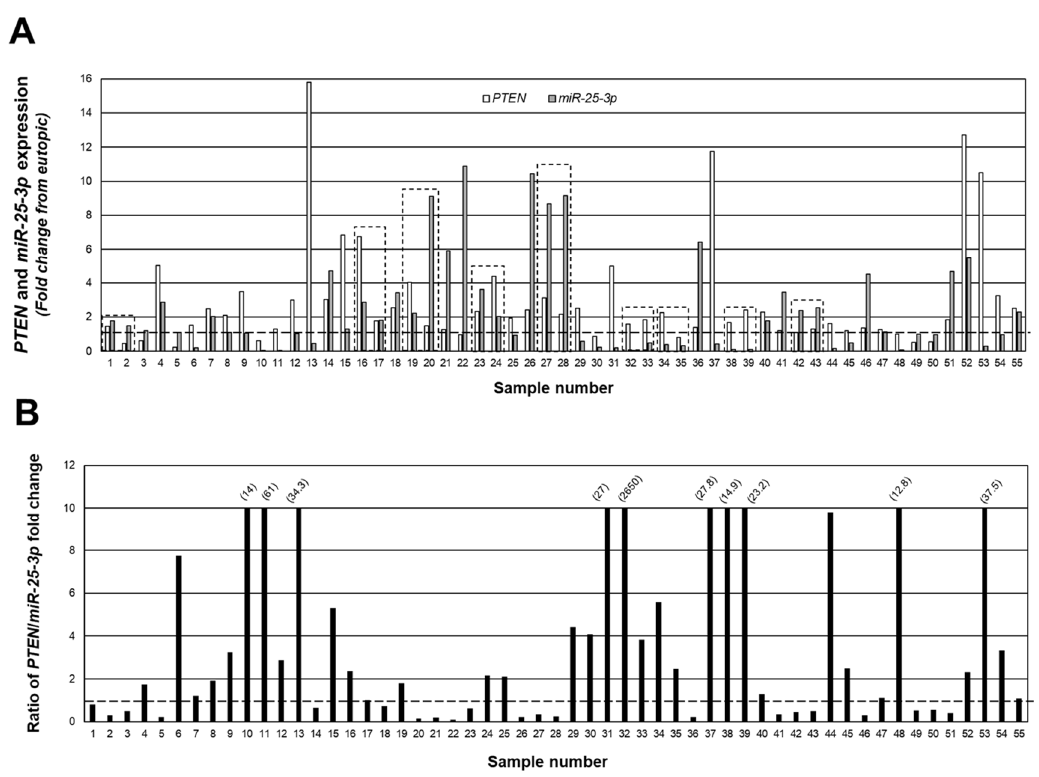
Figure 3. Individual peritoneal lesion expression and ratio of PTEN / miR ‐ 25 ‐ 3p expression. The fold change from matched eutopic endometrium for PTEN and miR ‐ 25 ‐ 3p were expressed for each lesion ( A ) as well as the ratio of PTEN / miR ‐ 25 ‐ 3p expression ( B ) to gain insight into the ratio/relationship between the two in individual lesions. Numbers in parenthesis reflect actual ratio values for samples number 10, 11, 13, 31, 32, 37, 38, 39, 48, and 53. These ratios were capped at 10 to allow depiction of ratios below 1.0 (indicated by broken line). Boxed areas indicate lesions obtained from the same patient at the time of surgery.